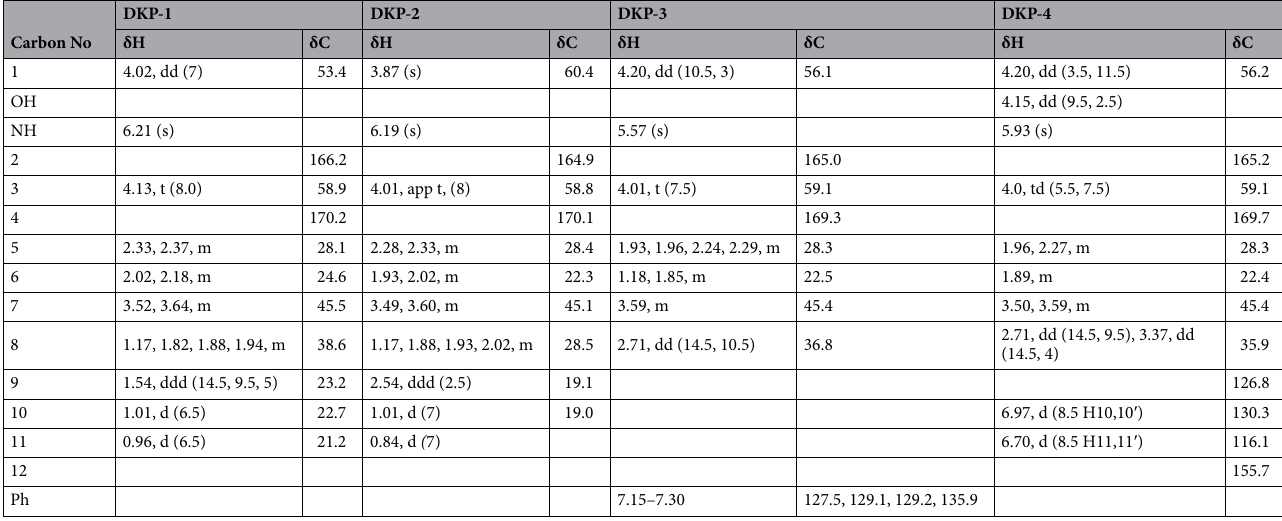
Table 1. NMR data for DKPs 1 – 4 in CDCl 3 (multi, J, Hz). s singlet; d doublet; dd doublet of doublets; m multiplet; t